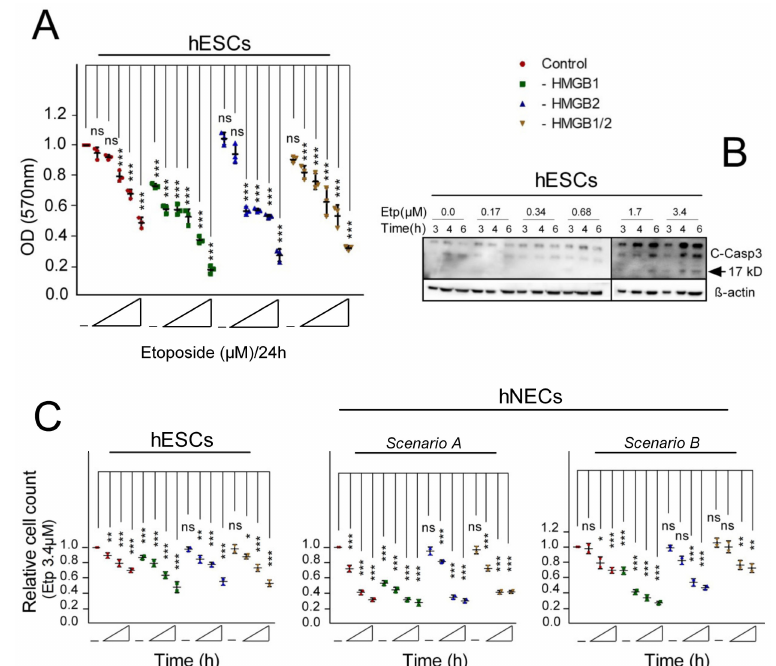
Figure 3. HMGB1 / 2 knockdown (KD) can di ff erentially modulate the cell viability of hESCs and hNECs treated with the anticancer drug etoposide. ( A ) hESCs were treated with increasing concentrations of etoposide (0.17, 0.68, 1.7, 3.4, and 17 µ M) for 24 h, and the growth curves were recorded by measuring the absorbance of crystal violet at 570 nm (results were normalized against untreated control cells, which were set as 1). ( B ) Cleavage of caspase-3 in etoposide-treated hESCs as revealed by Western blotting. Cellular lysates from control (empty vector-transfected) hESCs were treated with increasing concentrations of etoposide (0.17-3.4 µ M) for 3, 4, or 6 h. Equal loading of samples was verified using anti- β -actin antibody. ( C ) Relative cell count of 3.4 µ M etoposide-treated hESCs and hNECs (prepared by Scenarios A or B) was measured using the Cedex automated cell counting system (Roche Diagnostics, Mannheim, Germany) at 0, 6, 12, and 24 h (left to right). Data were analyzed using Bonferroni post hoc test and represent the mean and SD of three independent experiments (* p < 0.05; ** p < 0.001; *** p <